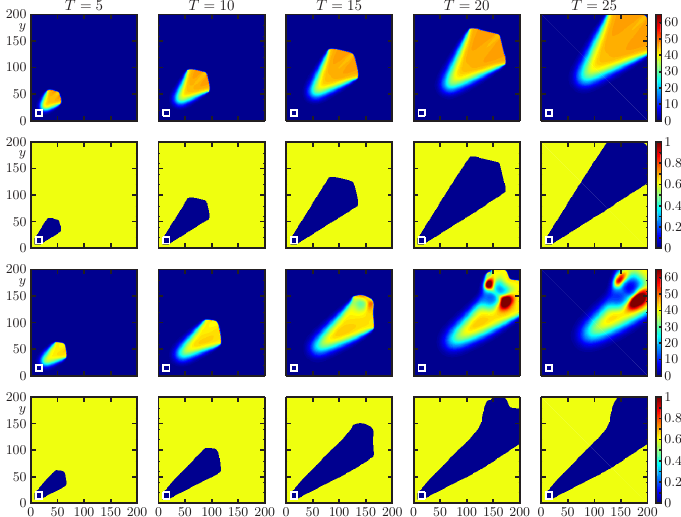
Figure 5. Scenarios 2.1 and 2.2: simulation of the propagation of a forest fire on a flat domain (first and second row) and on a domain with topography (third and fourth row), at indicated simulated times. T 1 Here and in Figure 6, the first and third row show temperature and the second and fourth row show fuel, and small white square indicates the location of the initial